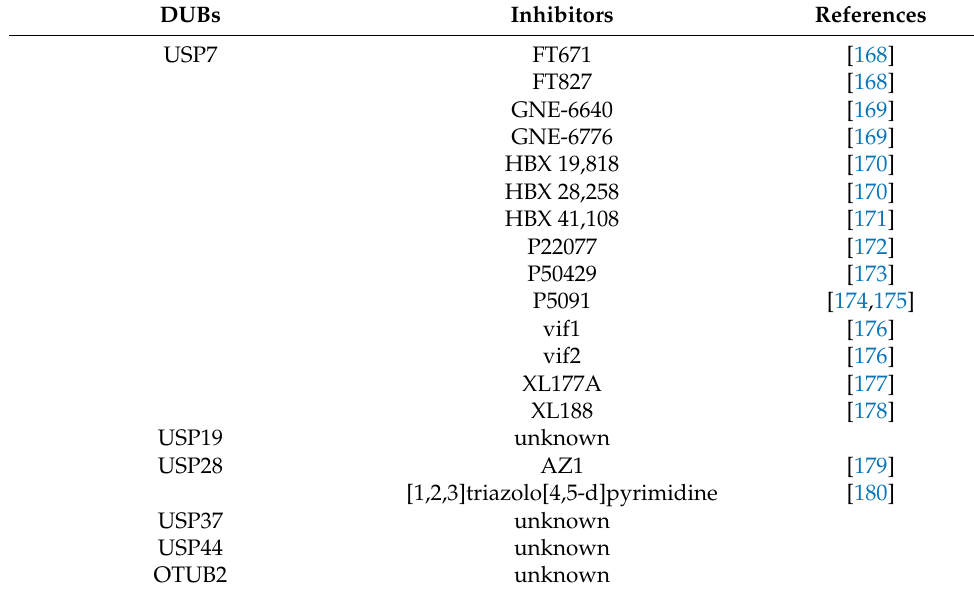
Table 2. The list of DUBs and inhibitors involved in the Warburg